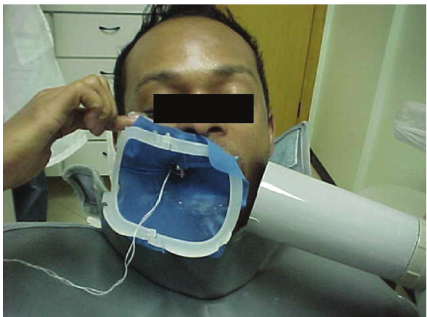
Figure 1: Extraoral technique used for maxillary molar in case report 1.